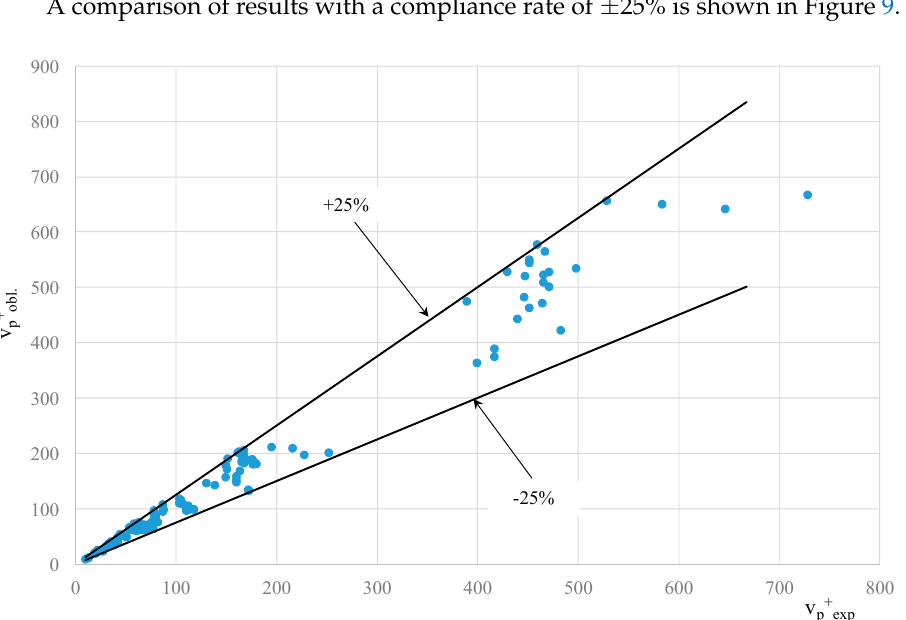
Figure 9. Dependence of dimensionless velocity v + p . reg obtained by dimensional analysis on the value obtained in experimental studies v + p .exp for